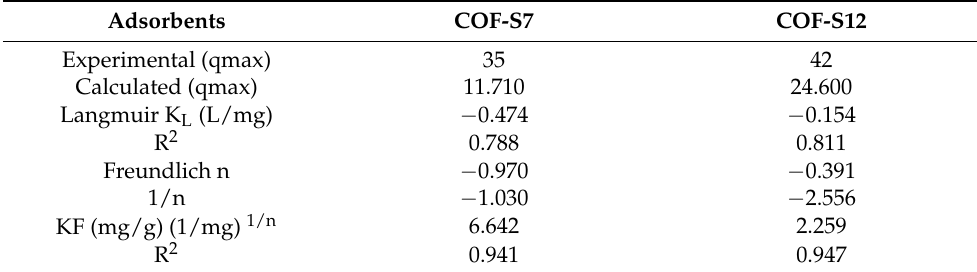
Figure 11. ( a ) NAP removal efficiency of COF-S7 and COF-S12 ( b ) NAP adsorption capacity of COF-S7 and COFS12 ( c ) Effect of pH on the adsorbed amounts of NAP over synthesized COFs at fixed dosage (0.05 g) and constant time, (270 min). Table 2. Isotherm constants for naproxen adsorption in